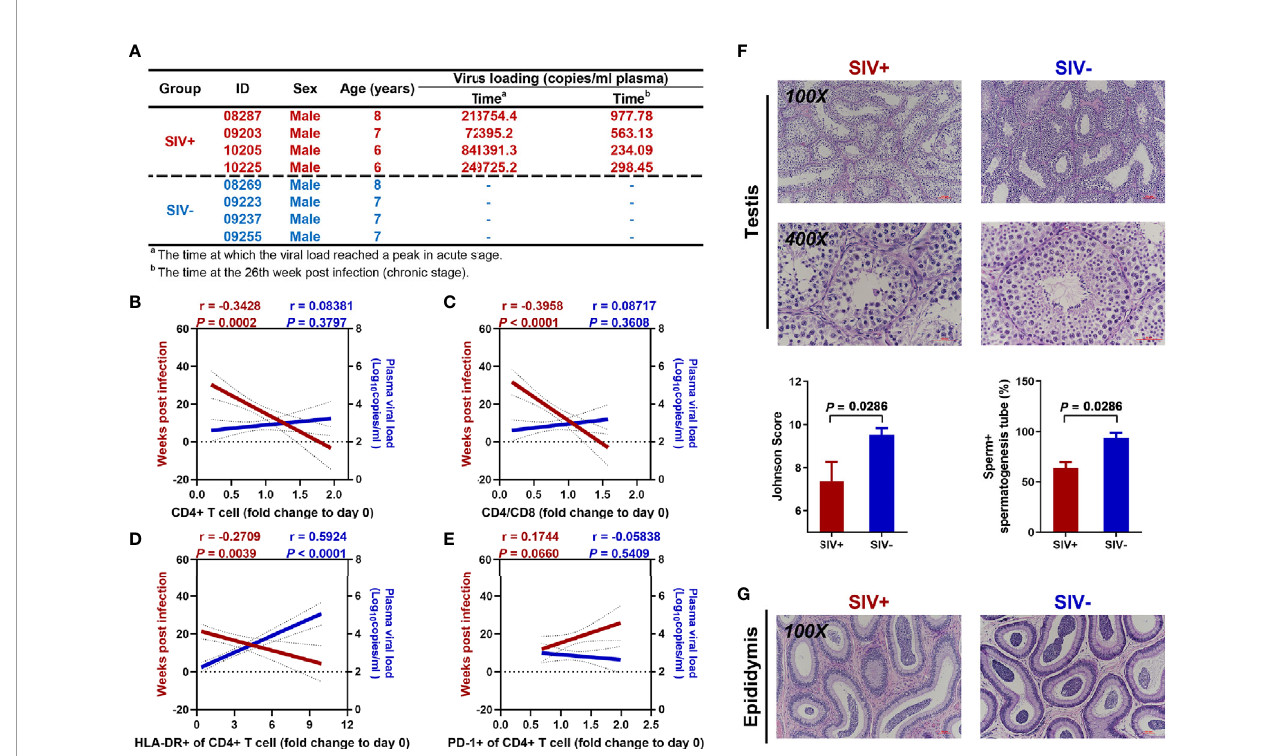
FIGURE 1 | Continuous disease progression and spermatogenic dysfunction in NPMs with long-term SIVmac239 infection. (A) Characteristics of enrolled macaques; (B) Correlation analysis of CD4+ T cell count with duration of infection and viral load in plasma; (C) Correlation analysis of CD4+/CD8+ cell ratio with duration of infection and viral load in plasma; (D) Correlation analysis of proportion of CD4+ T cells expressing HLA-DR with duration of infection and viral load in plasma; (E) Correlation analysis of proportion of CD4+ T cells expressing PD-1 with duration of infection and viral load in plasma; (F) Testicular H&E staining and pathological analysis; (G) Epididymal H&E